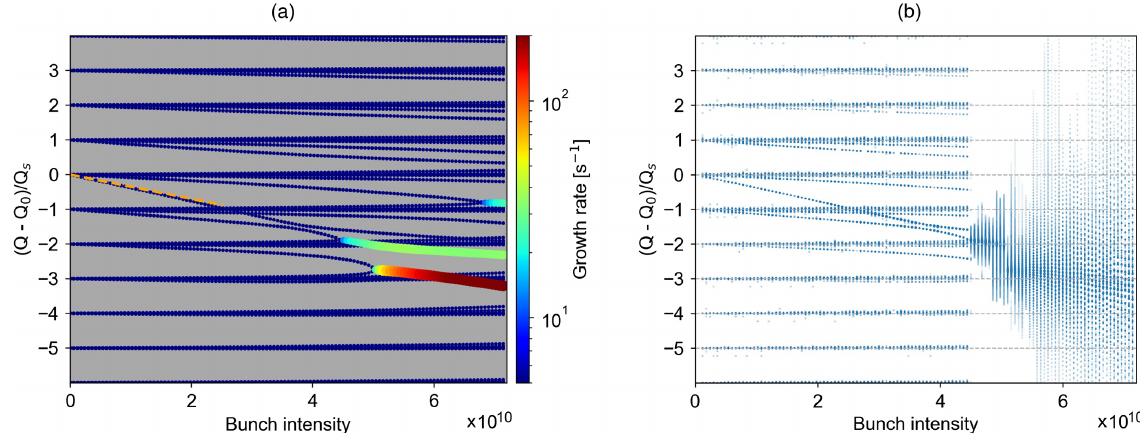
.FIG. 13. (a) Frequencies of the eigenmodes computed with the Vlasov method for the case of a broad-band resonator wakefield in the absence of quadrupolar forces, W quad ð z Þ ¼ 0 (the color code is proportional to the corresponding growth rate). (b) Spectrum of the transverse motion for the same configuration, computed using macroparticle simulations with the P y HEADTAIL impedance